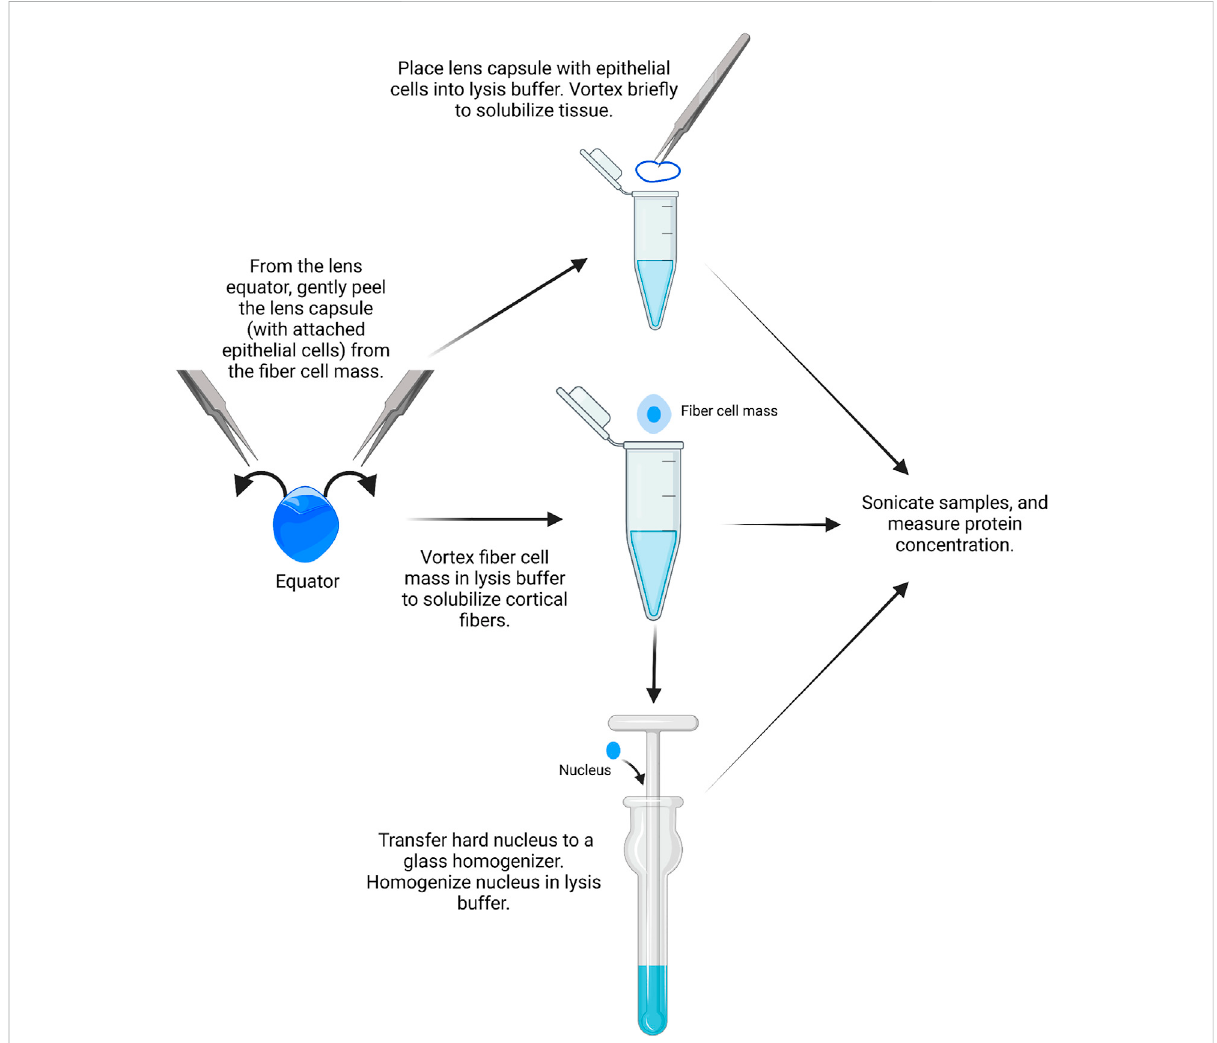
FIGURE 3 Epithelial, cortical fi ber, and nuclear fi ber protein sample isolation. Remove the lens capsule and isolate the protein sample from the lens epithelialcells.The fi bercellmasscanthenbevortexedtosolubilizecortical fi bercells,leavingahardlensnucleus.Thehardlensnucleuscanthenbe homogenized to create nuclear fi ber protein lysates. The image was drawn using Biorender and not drawn to